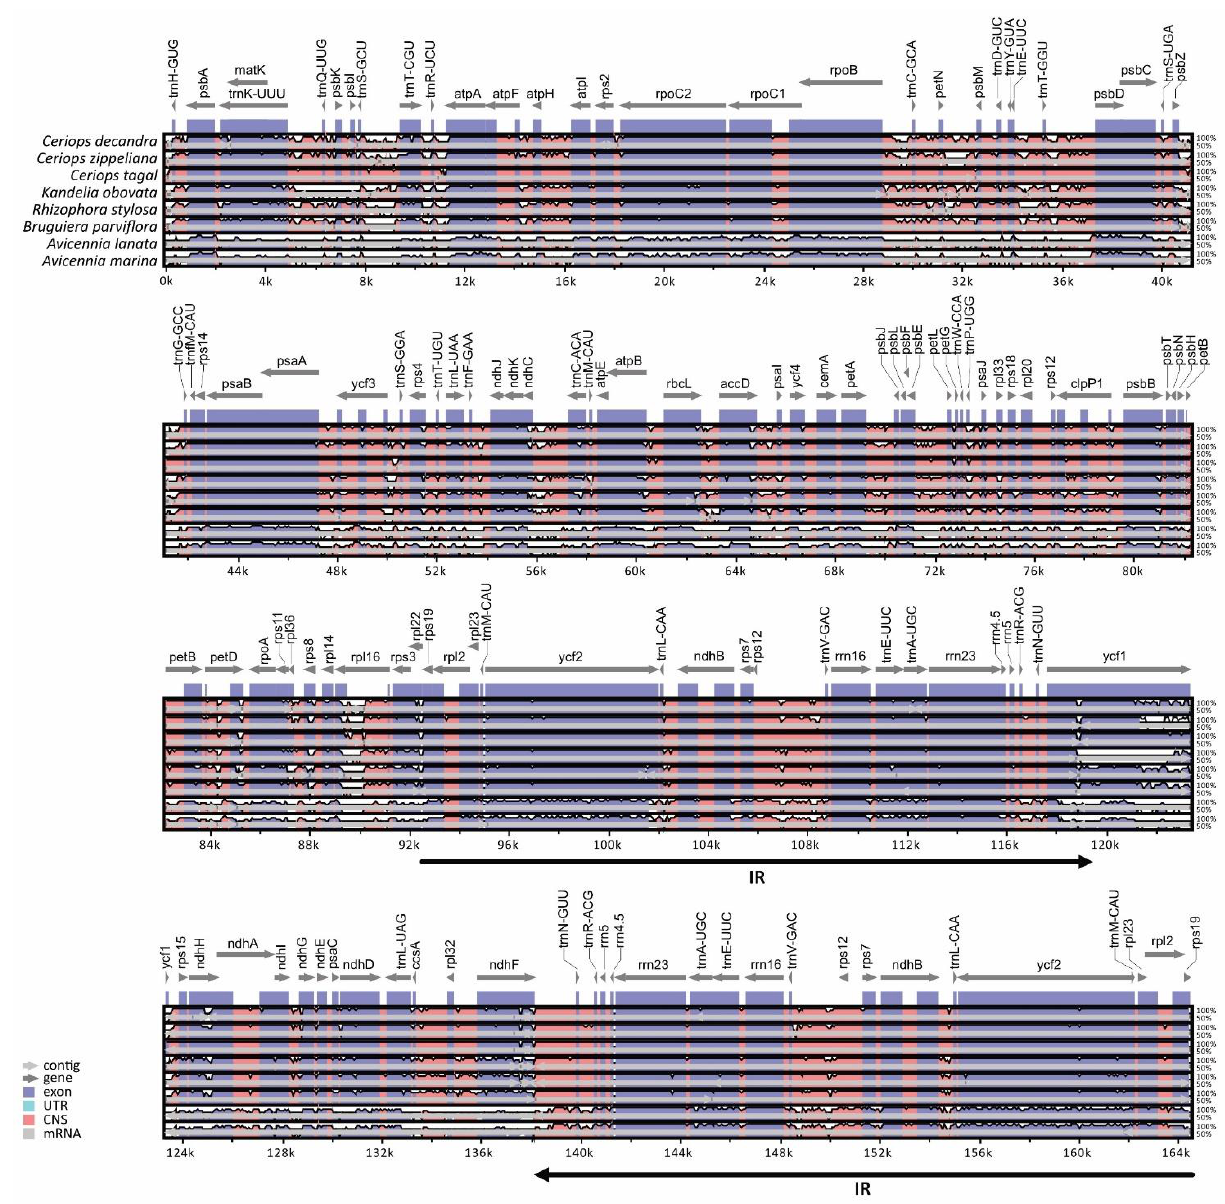
Figure 2. Alignment map of 8 mangrove chloroplast genomes in Rhizophoraceae and Acanthaceae. Horizontal axis is genome position, whereas vertical axis shows sequence identity. Grey arrows indicate genes and transcriptional directions, and black arrows indicate IR regions. Exons and conserved non-coding sequences (CNS) are shown in blue and red, respectively.